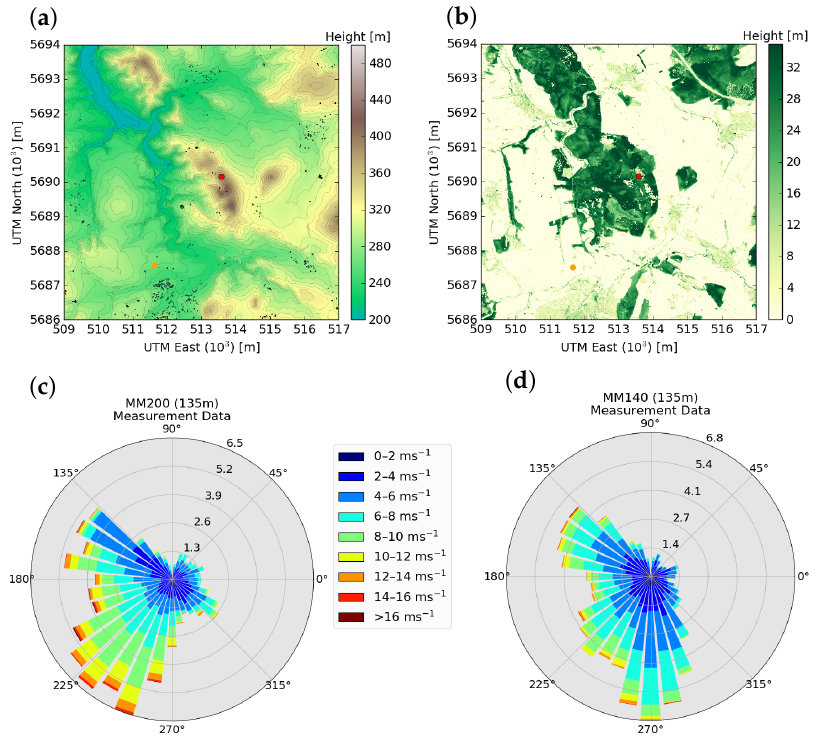
Figure 2. Terrain height ( a ) and forest heights ( b ) of the Rödeser Berg site close to Kassel in central Germany. The red dot marks the position of the met mast at the hill top (MM200), the orange dot the second met mast (MM140). ( c , d ) show the respective wind roses during the measurement period. (Terrain and forest height data source (ALS data): Hessische Verwaltung für Bodenmanagement und